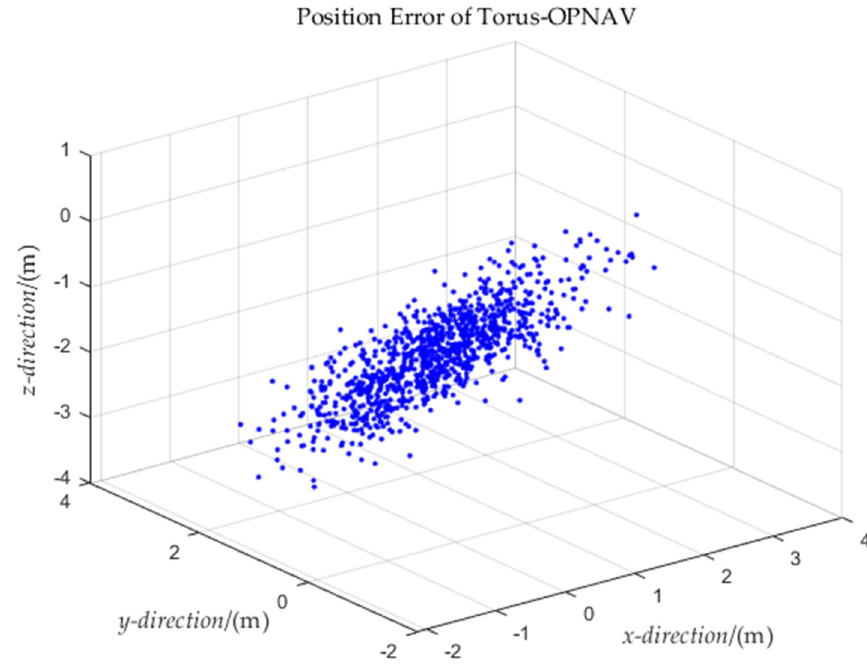
Figure 10. Monte Carlo positioning results of Torus-OPNAV.